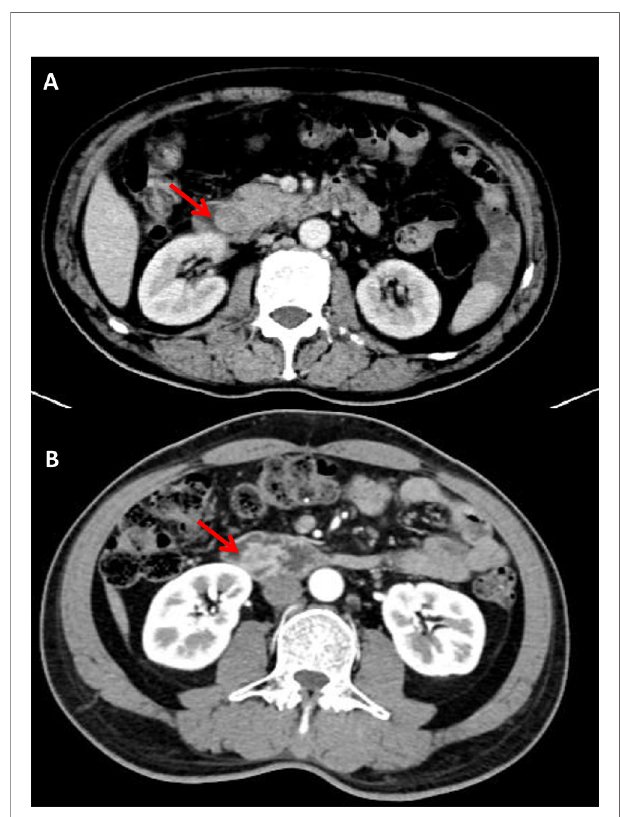
FIGURE 3 | Benign enlargement of papilla in a 79 years old female. The shape of bulging papilla was regular (arrow) with a size of 18.6 × 19.7 mm (A) ; Malignant enlargement of papilla in a 64 years old male, post-contrast image depicted irregular shape of bulging papilla with a size of 25.1 × 15.4 mm (arrow) (B)